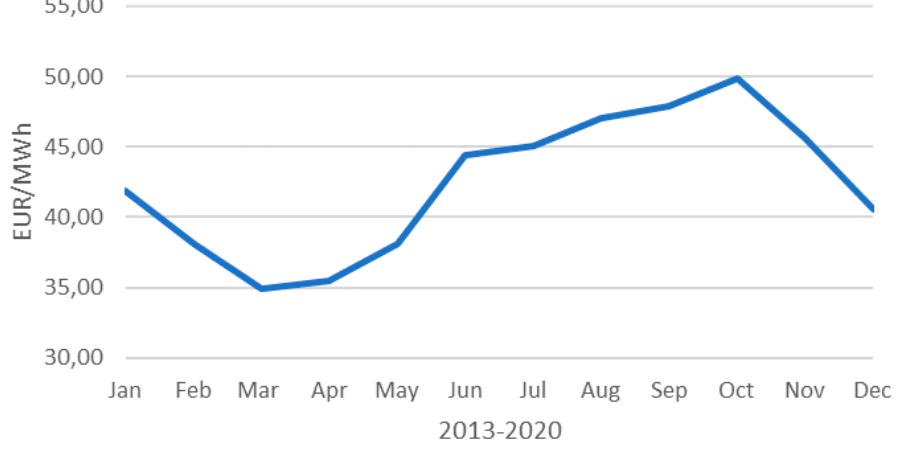
Figure 4. Dynamics of Nord Pool average Elspot prices.